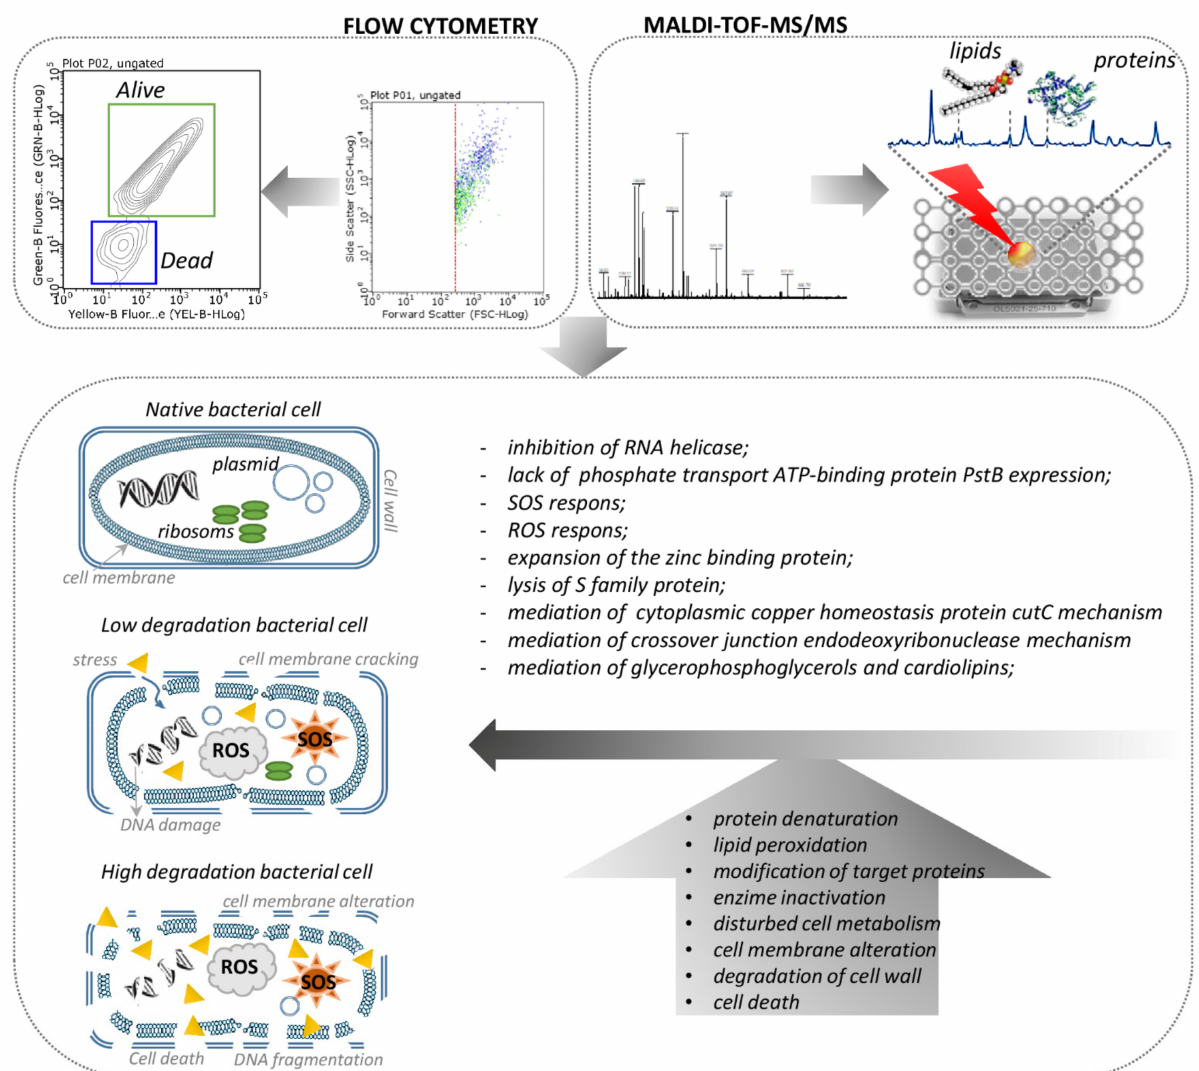
Figure 11. The effects of ZnO NPs and its complexes with ampicillin and tetracycline, along with antibiotics alone on cell metabolism and